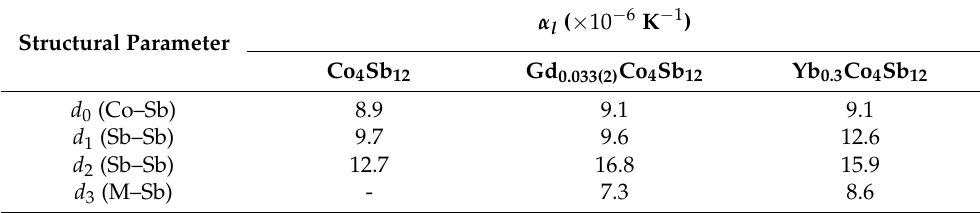
Table 2. Linear thermal-expansion coefficients ( α l ) evaluated for the bonds Co–Sb, Sb–Sb, and M–Sb in both unfilled [19] and filled (M = Gd and Yb [45]) Co 4 Sb 12 skutterudites, normalized with respect to the 300-kelvin bond length.